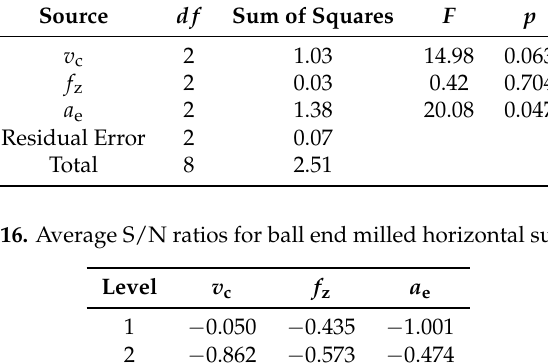
Table 15. Analysis of variance for S/N ratios of ball end milled horizontal surfaces, R 2 = 97.26%. Source